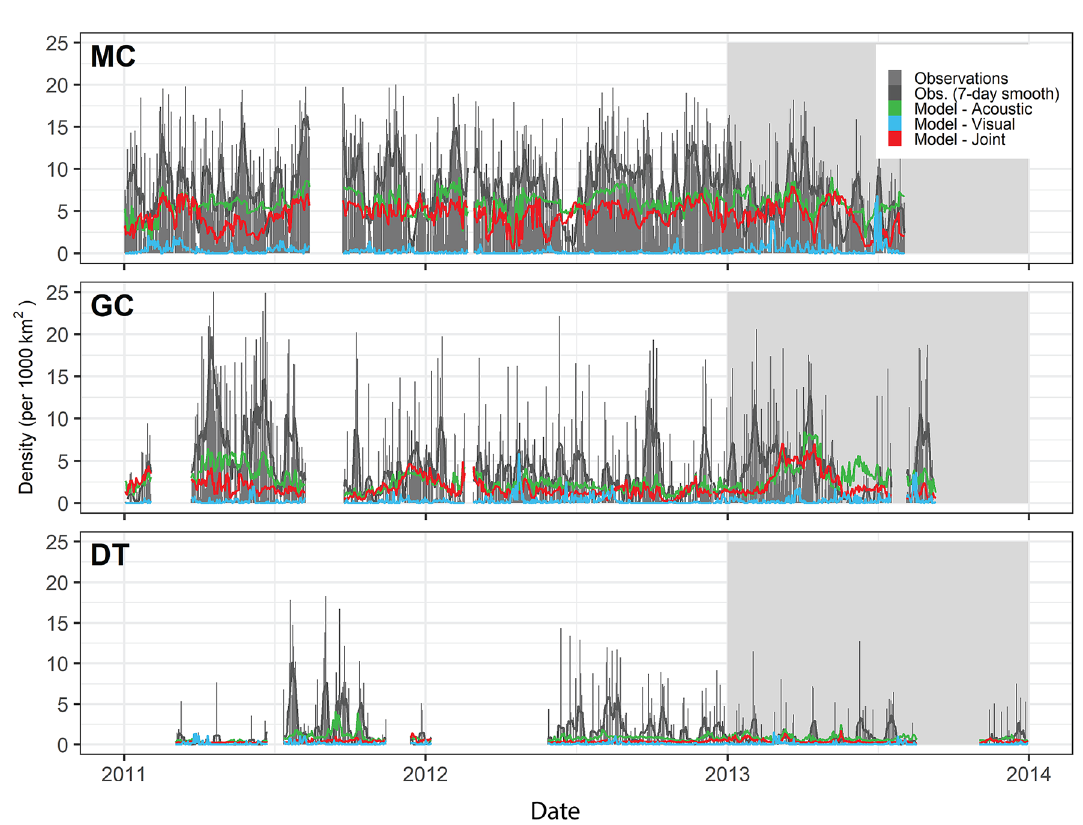
Figure 7. Time series of daily observed and neural network model-predicted sperm whale densities from the passive acoustic monitoring sites MC, GC, and DT. Markings as in Fig.